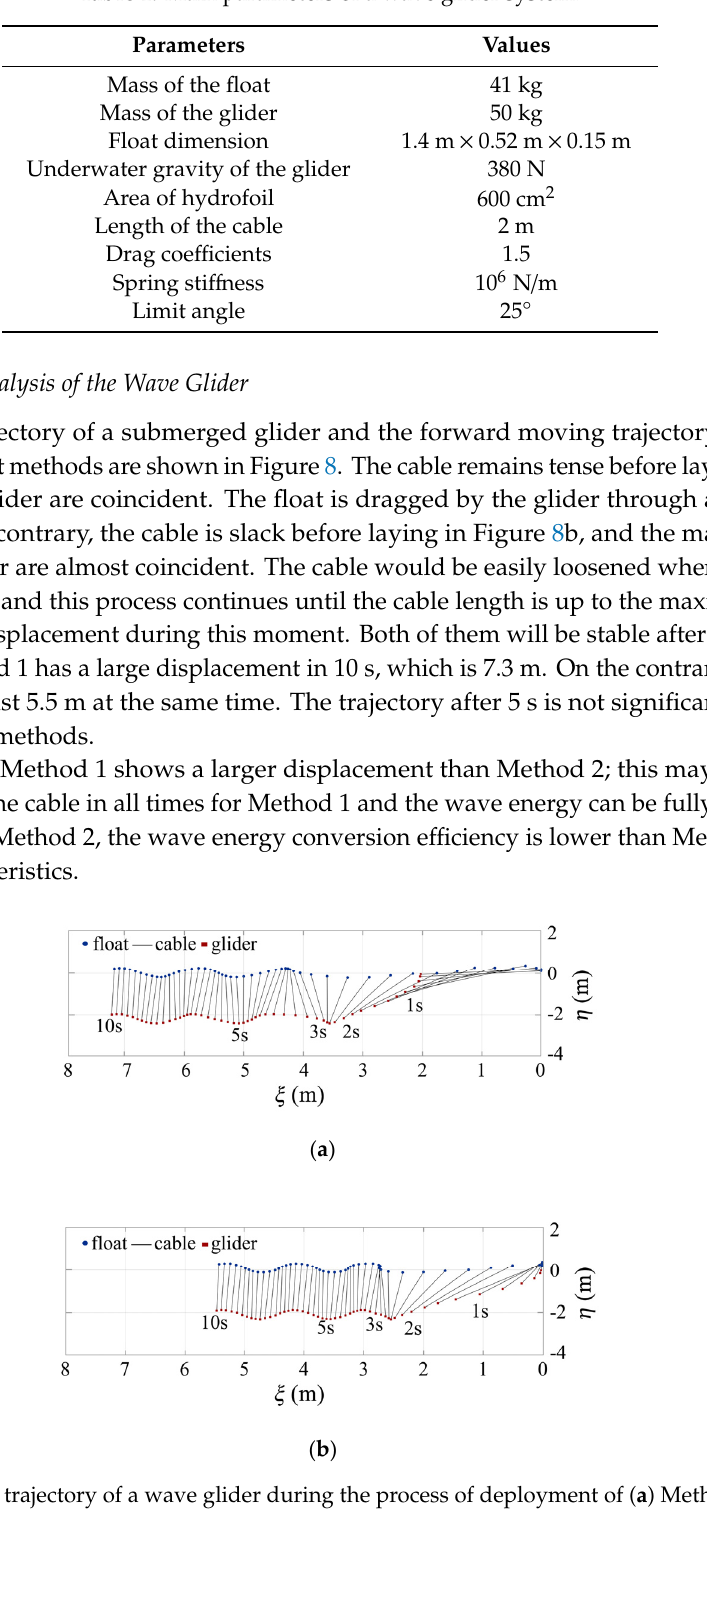
Table 1. Main parameters of a wave glider system.